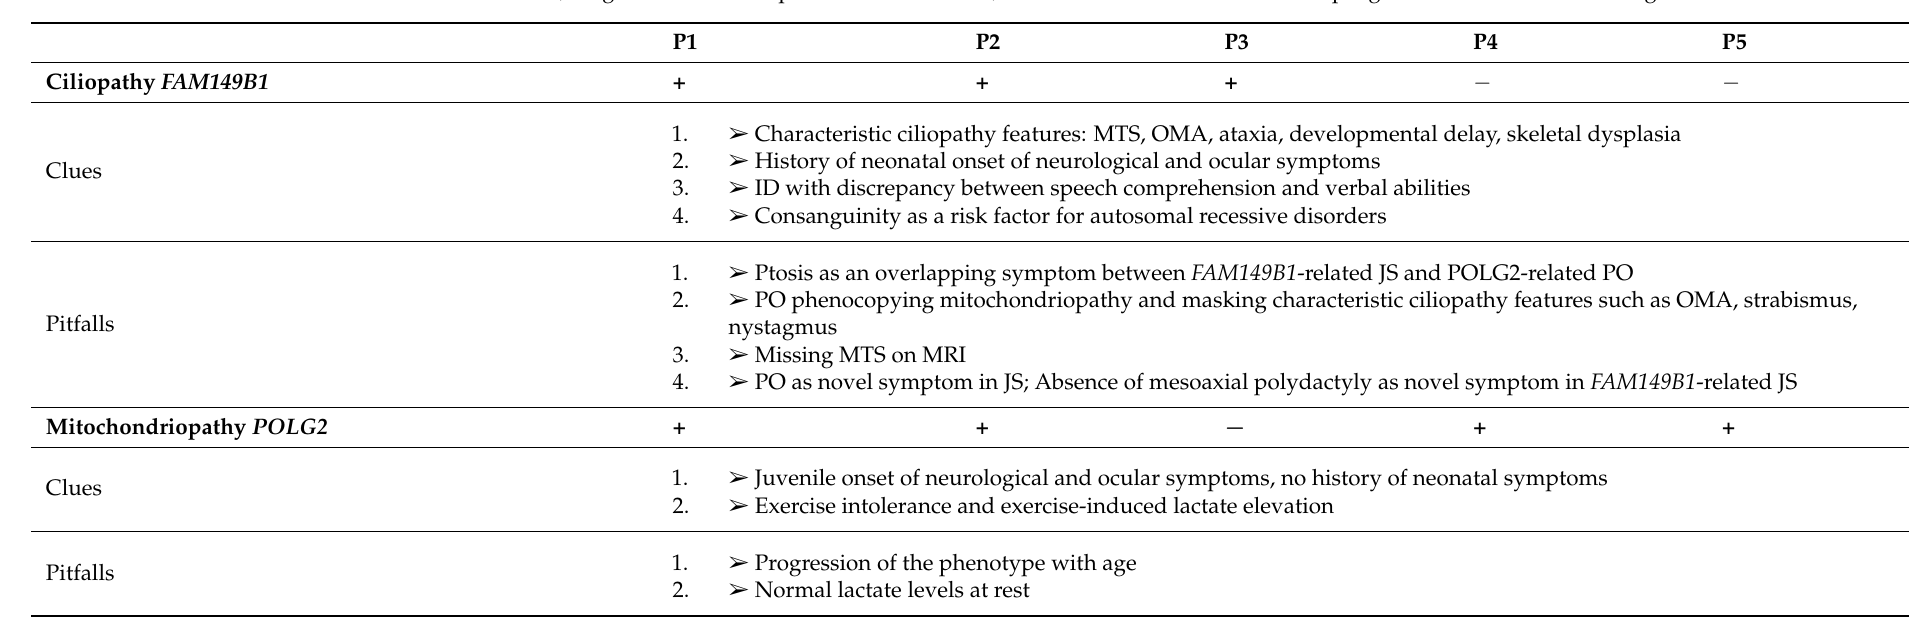
Table 2. Clinical features, diagnostic clues and pitfalls for FAM149B1 , POLG2 and KMT2B related multiple genetic disease in five